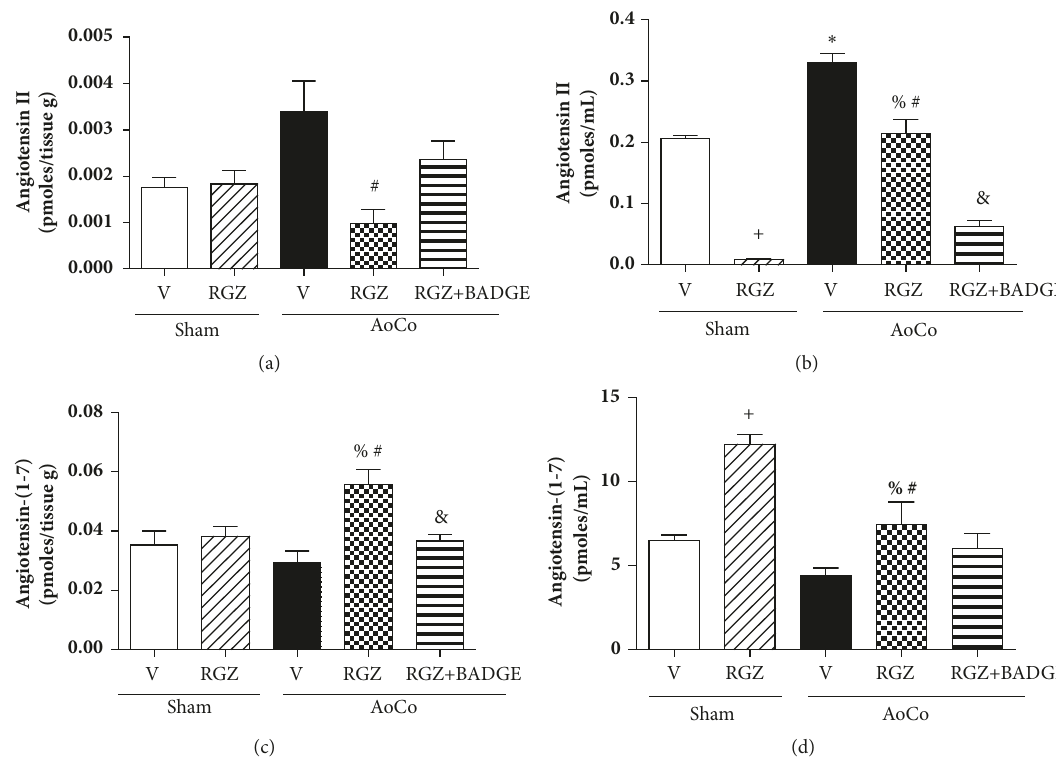
Figure 5: Effect of rosiglitazone (RGZ) on angiotensin II and angiotensin-(1-7) production. Values obtained from aorta’s homogenate (a, c) and serum (b, d) from sham or aortic coarctated (AoCo) rats treated with vehicle (V), rosiglitazone (5mg/kg, RGZ), or RGZ + bisphenol A diglycidyl ether (120 mg/kg, RGZ+BADGE). The values represent the mean ± SEM (n=6 animals per group). One-way analysis of variance (ANOVA) post Tukey. ∗ P < 0.05 Sham-V vs. AoCo-V, + P < 0.05 Sham-V vs. Sham-RGZ, % P < 0.05 Sham-RGZ vs. AoCo-RGZ, # P < 0.05 AoCo-V vs. AoCo-RGZ, and & P < 0.05 AoCo-RGZ vs. AoCo-RGZ+BADGE.